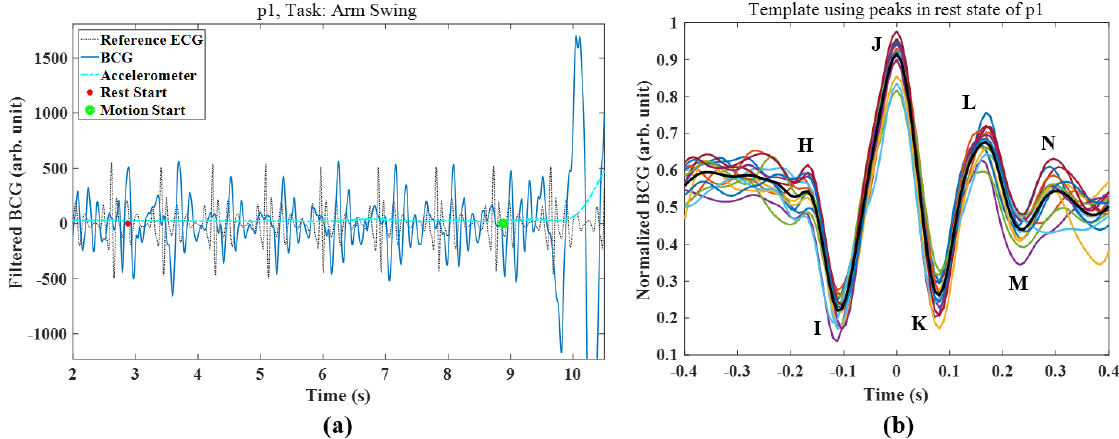
Figure 3. ( a ) BCG with reference ECG and accelerometer signals; ( b ) BCG template (bold) using serially validated peaks in the rest state of p1.